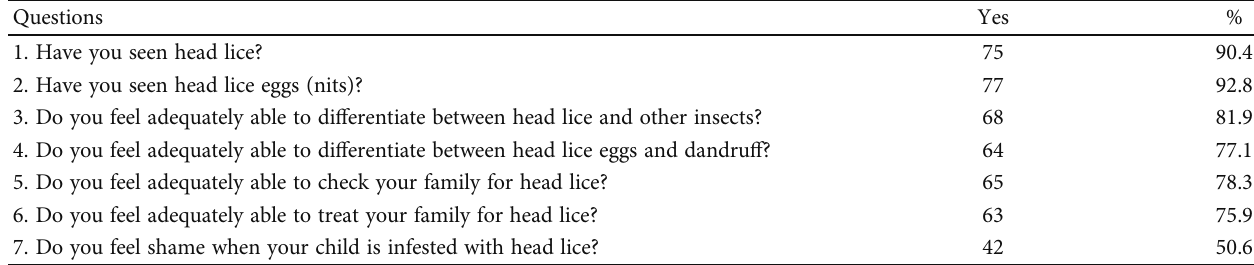
Table 4: Parental attitudes concerning head lice prevention in schoolchildren in Lak Hok subdistrict.